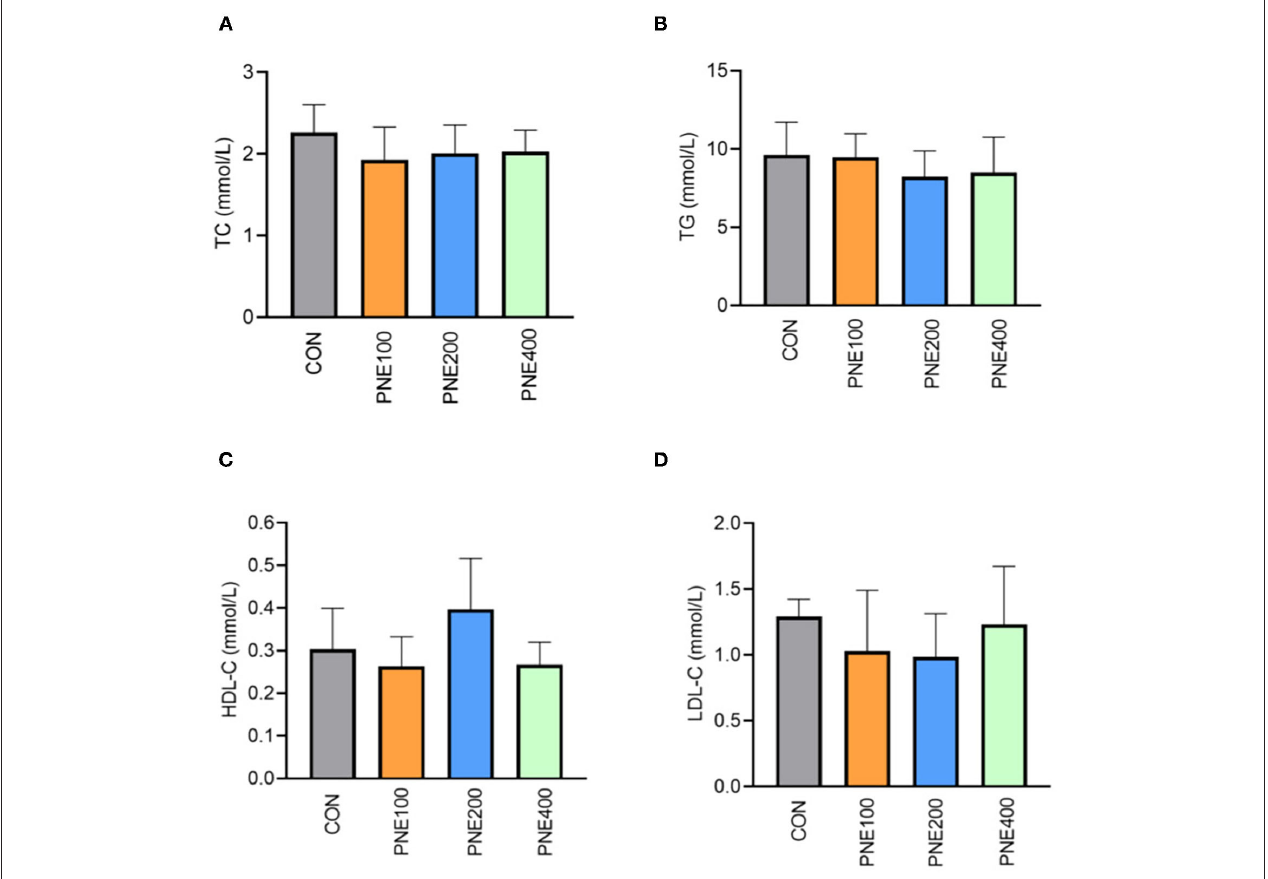
FIGURE 2 | Effect of pine needle extract (PNE) supplementation on serum lipid metabolism indices TC (A) , TG (B) , HDL-C (C) , and LDL-C (D) of laying hens. TC, total cholesterol; TGs, triglycerides; HDL-C, high-density lipoprotein cholesterol; LDL-C, low-density lipoprotein cholesterol. n = 6 per group, data are expressed as means ±